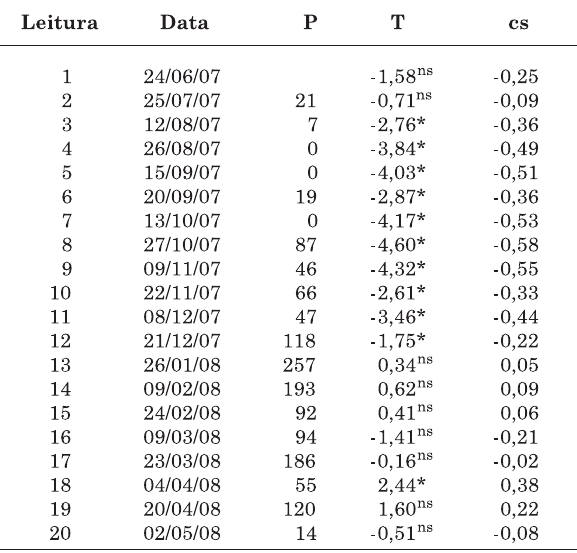
Quadro 3. Estatística do teste de Spearman (T), coeficiente de correlação de Spearman (cs) em diferentes datas de amostragem e lâmina de precipitação pluvial acumulada (P) durante o respectivo período de monitoramento da umidade do